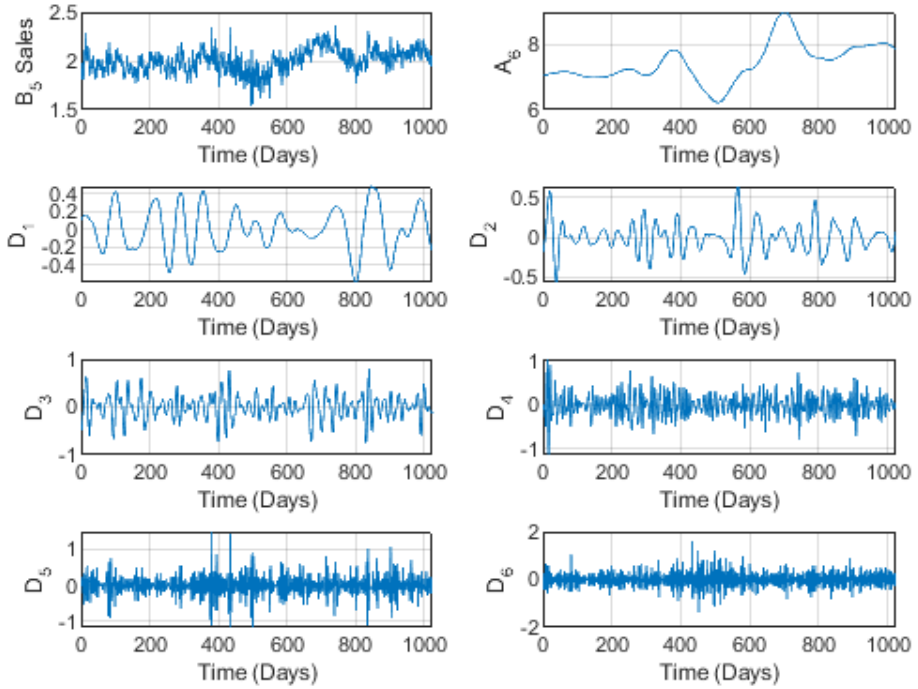
Figure 10. The wavelet decomposition of the EIC brand B 5 sales at level 6.